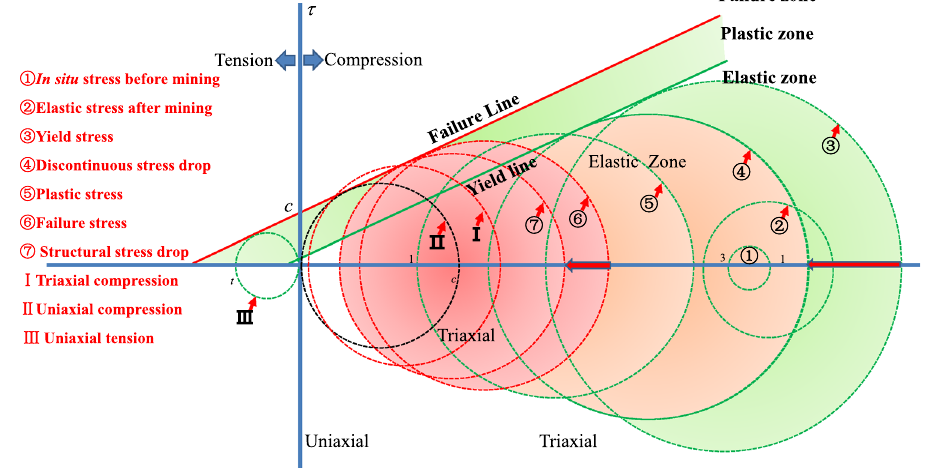
Fig. 10 Mining-induced evolution of Mohr’s circle considering unloading